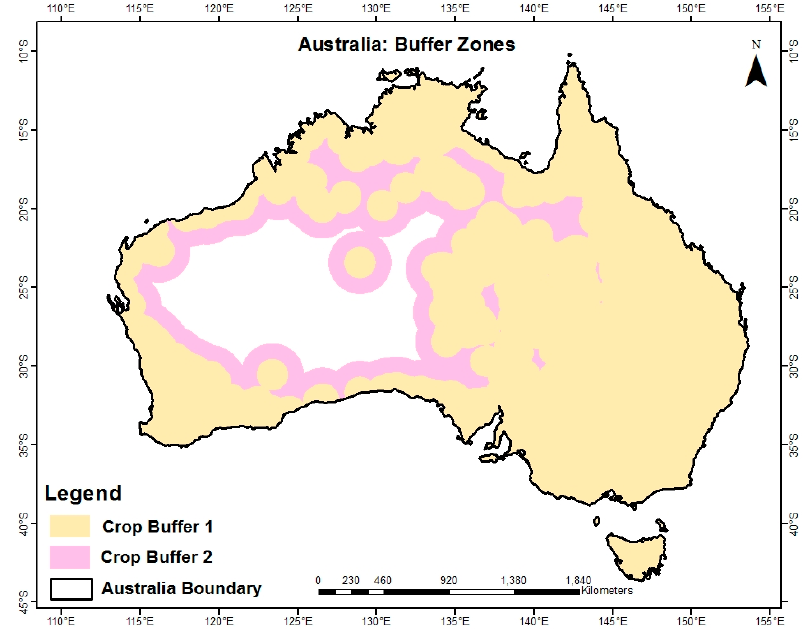
Figure 10. Crop buffer zones delineated using Euclidean Distance buffering approach.